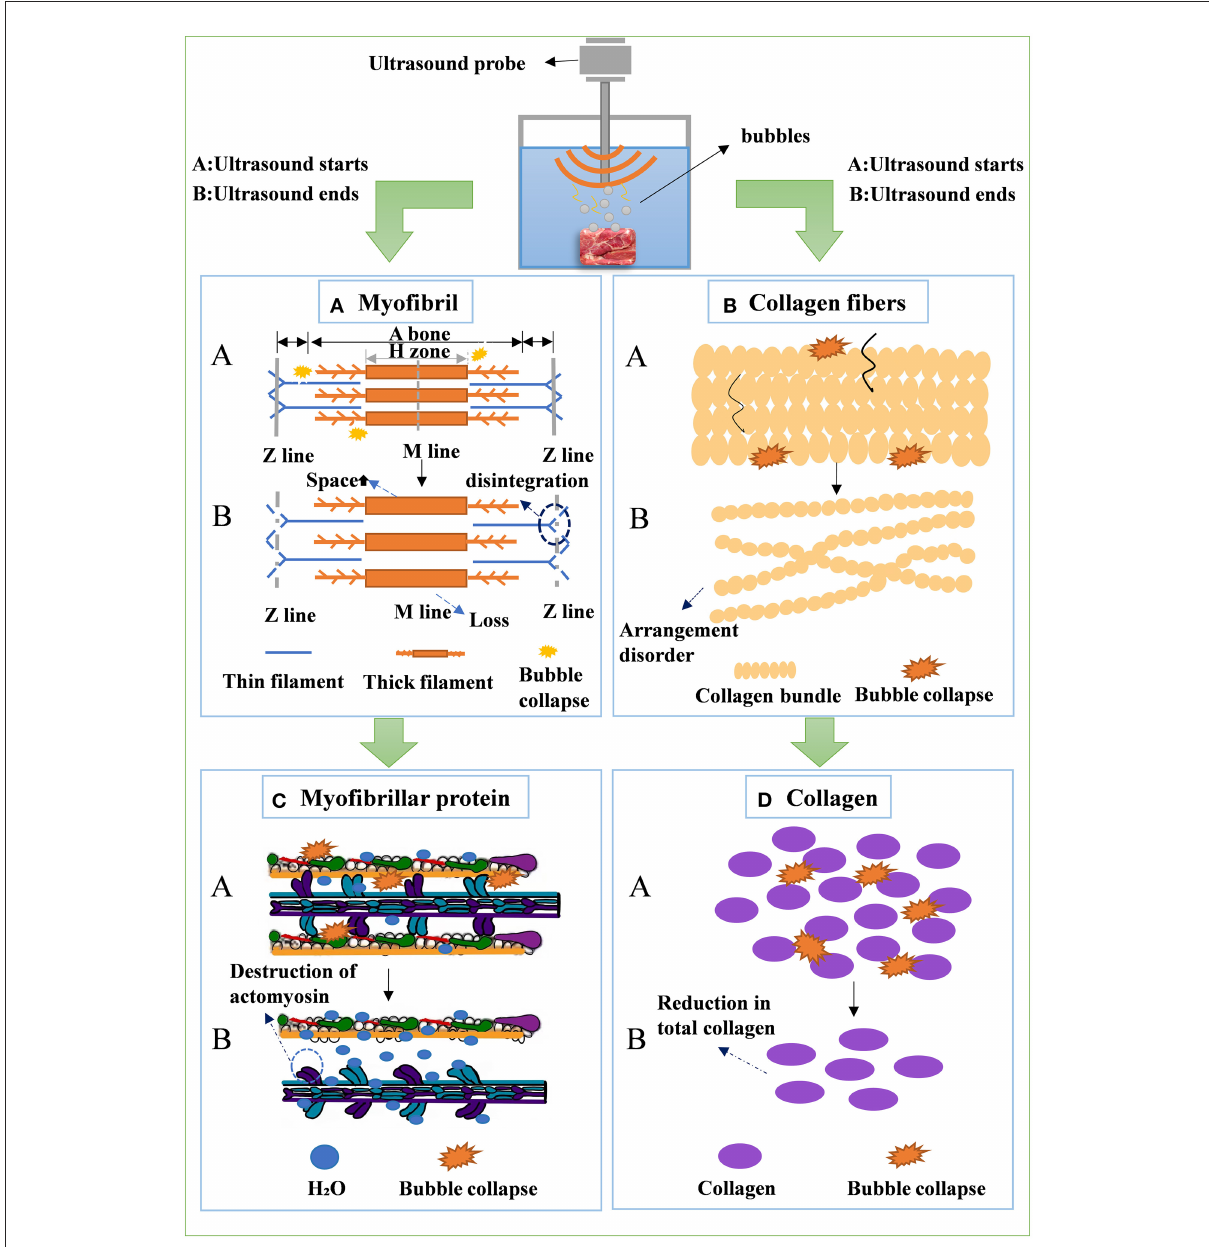
FIGURE4 Mechanism of the effects of ultrasound technology on myofibril (A) , collagen fibers (B) , myofibrillar protein (C) , and collagen (D) of